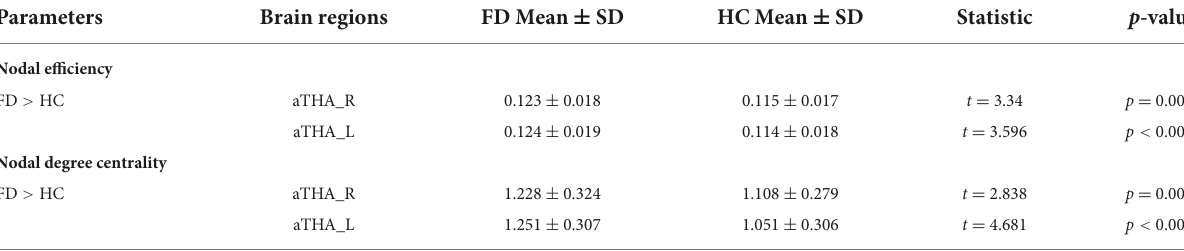
TABLE 3 Between-group differences in the regional topological properties.